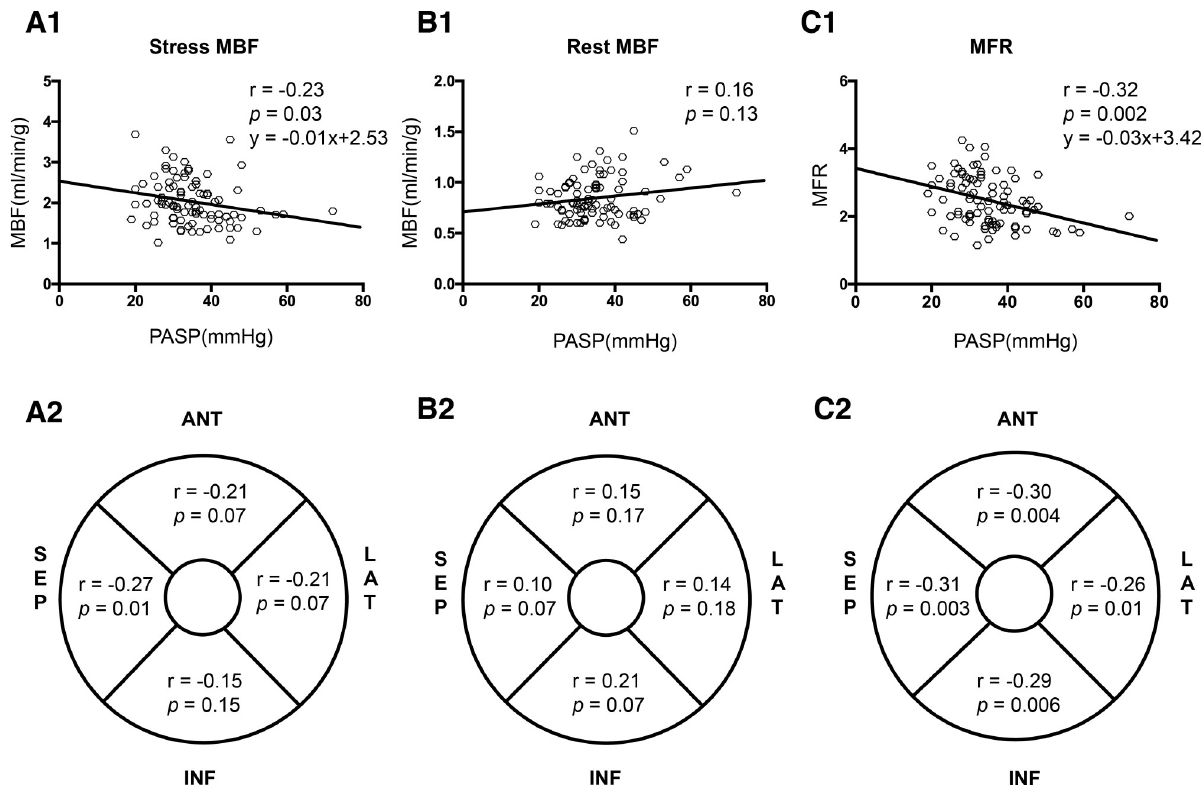
Fig 3. Correlation between PASP and PET parameters in the total HCM cohort. (A1,A2):correlation between PASP and global/regional stress MBF; (B1,B2): correlation between PASP and global/regional rest MBF; (C1,C2): correlation between PASP and global/regional